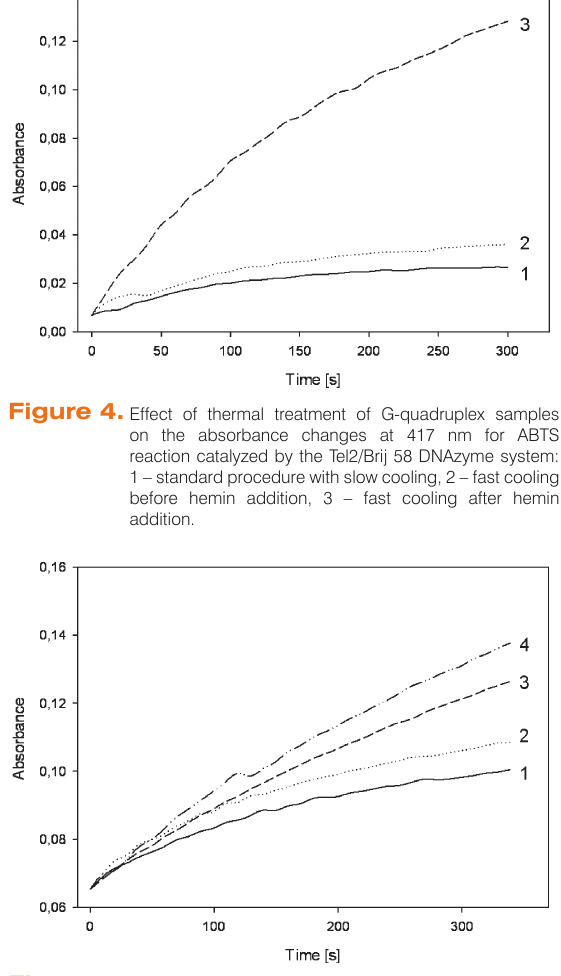
Figure 5. Temperature effect on the ABTS indicator reaction catalyzed by the Tel2/Brij 58 DNAzyme system, shown as absorbance changes at 417 nm: 1 – 25˚C, 2 – 30˚C, 3 – 35˚C, 4 - 40˚C.